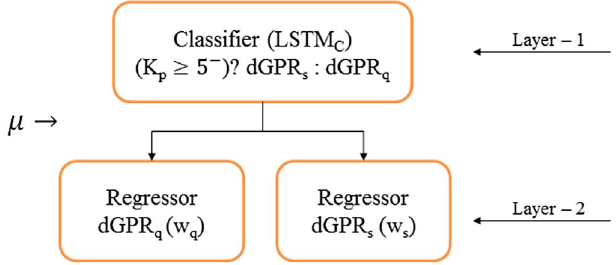
Fig. 5. Proposed model ( l ) architecture: Classi fi er is deterministic in nature, and regressors are probabilistic in nature. The threshold for the classi fi er is K p = 5 (cid:3) . Here, w q & w s are the variable training windows for two regressors. For details refer